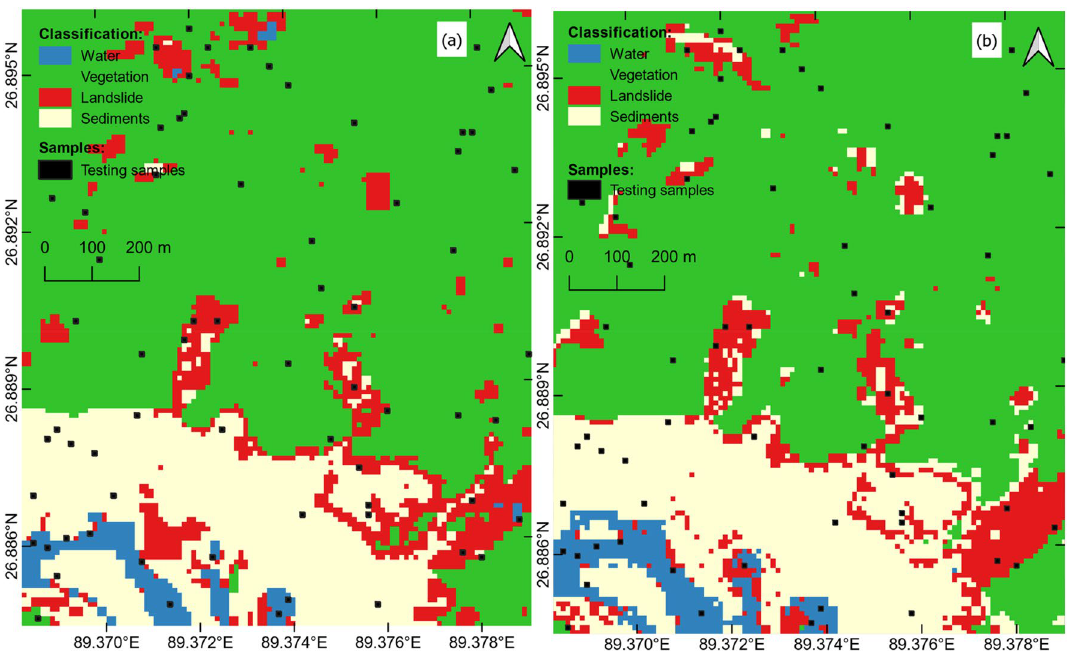
Fig. 7 Land classification map of the study area produced using SCP, a Unsupervised classification map using ISODATA, b Supervised clas- sification map using RF algorithm. Geohazard attributes in consideration: Amochhu River, sediments/debris, and landslides